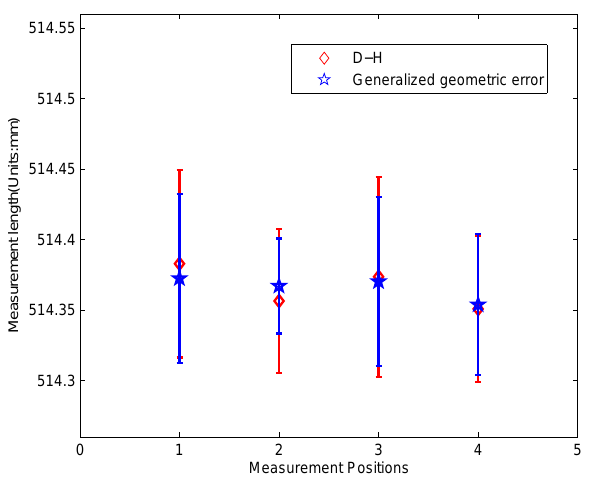
Figure 9. Comparison of the measurement results of length gauge using PACMM based on the Denavit-Hartenberg (D-H) and generalized geometric error